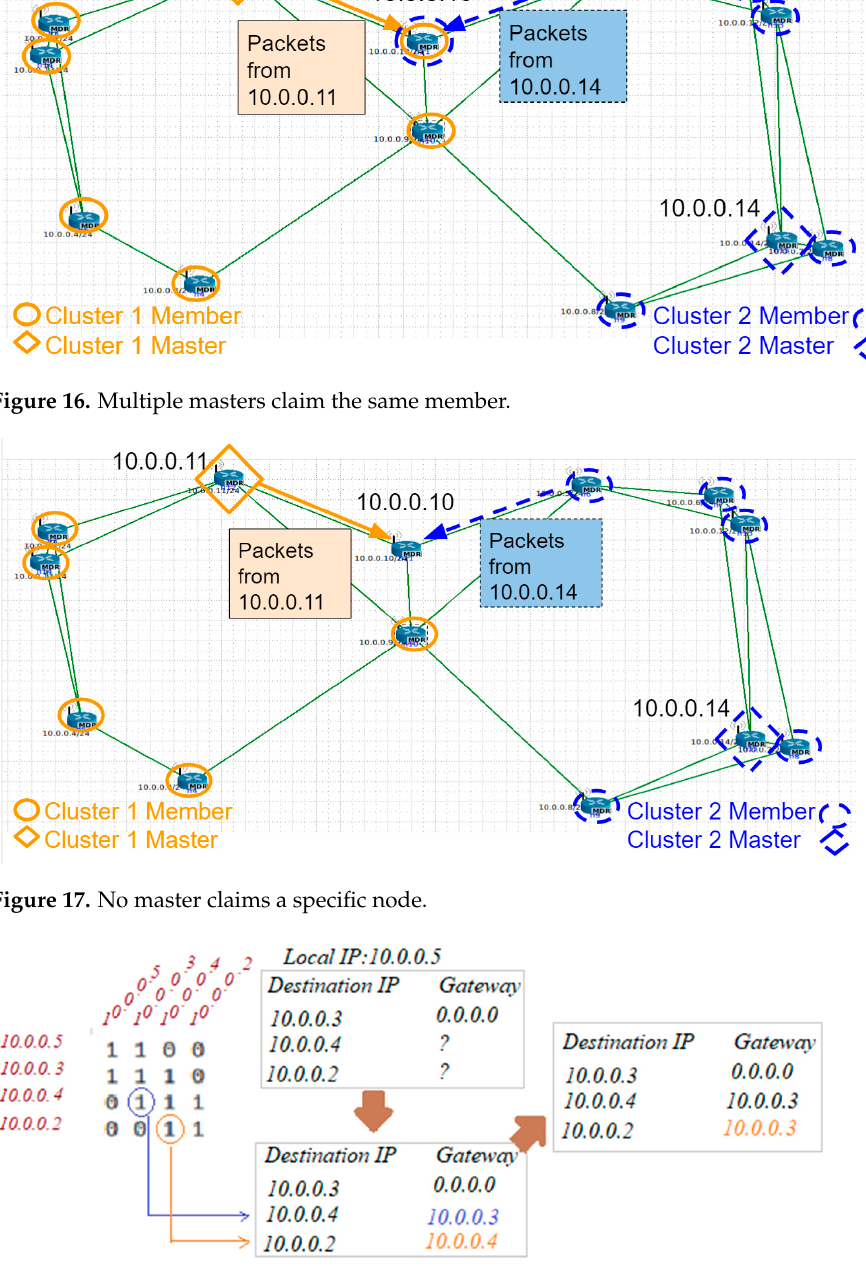
Figure 18. Adding skeleton node to the routing table by tracing the skeleton connection matrix .